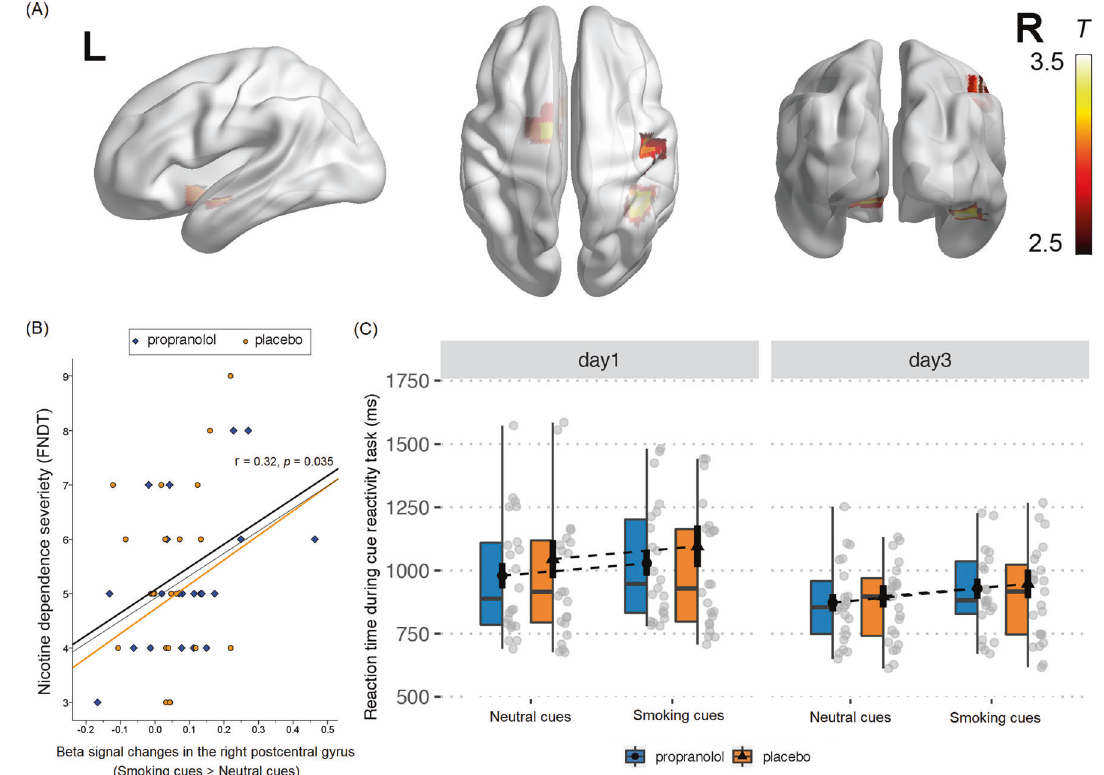
Fig. 4 Brian reactivity to smoking-related cues at baseline (day 1). A Brain regions that showed a signi fi cant increase in activation in response to smoking-related cues at baseline (smoking-related cues > neutral cues). The peak brain regions were the caudate and postcentral gyrus. B A positive correlation was found between the increase in postcentral gyrus activity and the severity of nicotine dependence, measured by FNDT scores. C Reaction time during the cue-reactivity paradigm, with a main effect of cue type (i.e., the reaction time for smoking-related cues was longer than for neutral cues) and time (i.e., the reaction time on day 3 was shorter than on day